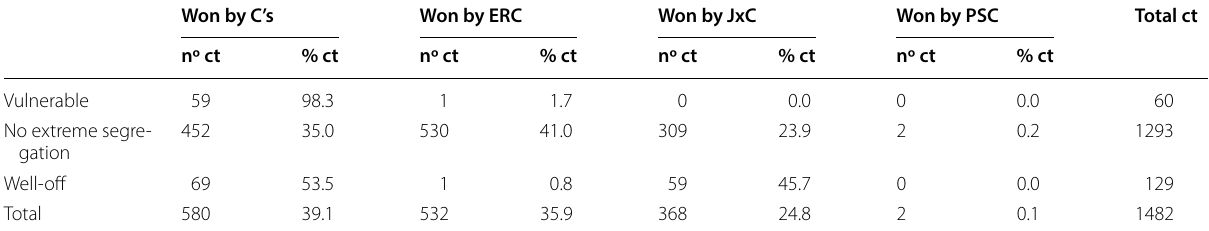
Table 3 Candidature that received the most votes in the elections to the Parliament of Catalonia in December 2017 according to the segregation of the census tracts. Source: Own elaboration from the data provided by the Generalitat de Catalunya and Barris i crisi (Blanco and Nel lo ·